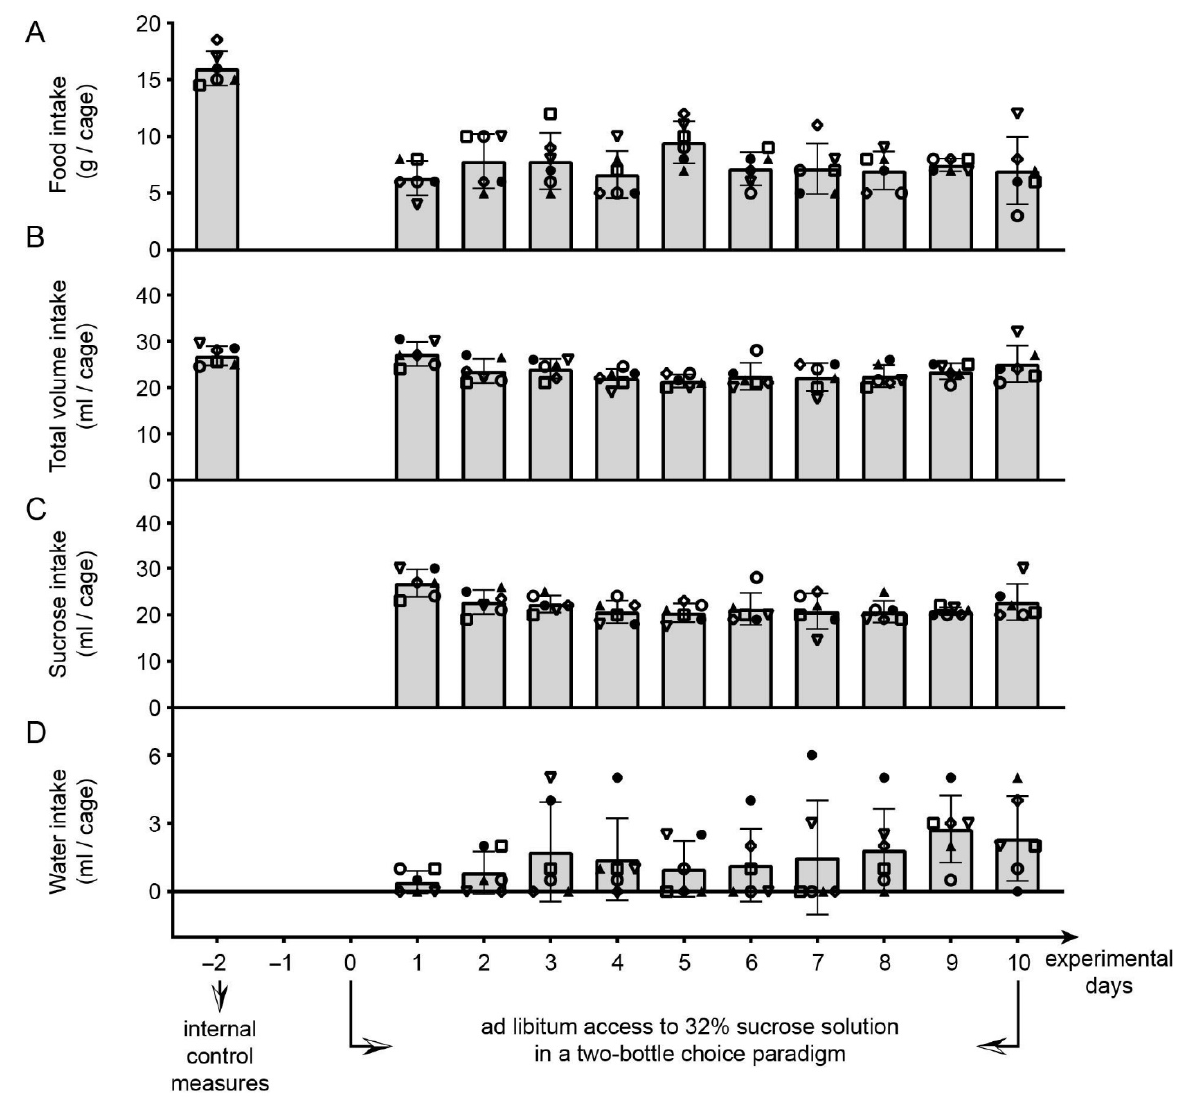
Figure 2. Consummatory activity of adult male C57BL/6J mice associated with ad libitum access to 32% sucrose solution in a two-bottle choice paradigm. Obtained results (( A ) Food intake; ( B ) Total volume intake; ( C ) Sucrose intake; ( D ) Water intake) are expressed as intake(s) per cage. Note that the total volume intake for the control measures also reflects water intake as for this measure the animals had no experience with sucrose (i.e., water was the only available liquid). Detailed statistical analysis (within-subject design, Wilcoxon matched pairs test) followed by Benjamini–Hochberg procedure did not reveal significant differences between measurements (including the condition when values representing total fluid intake were used as control values for water intake, although not given as a part of panel D).